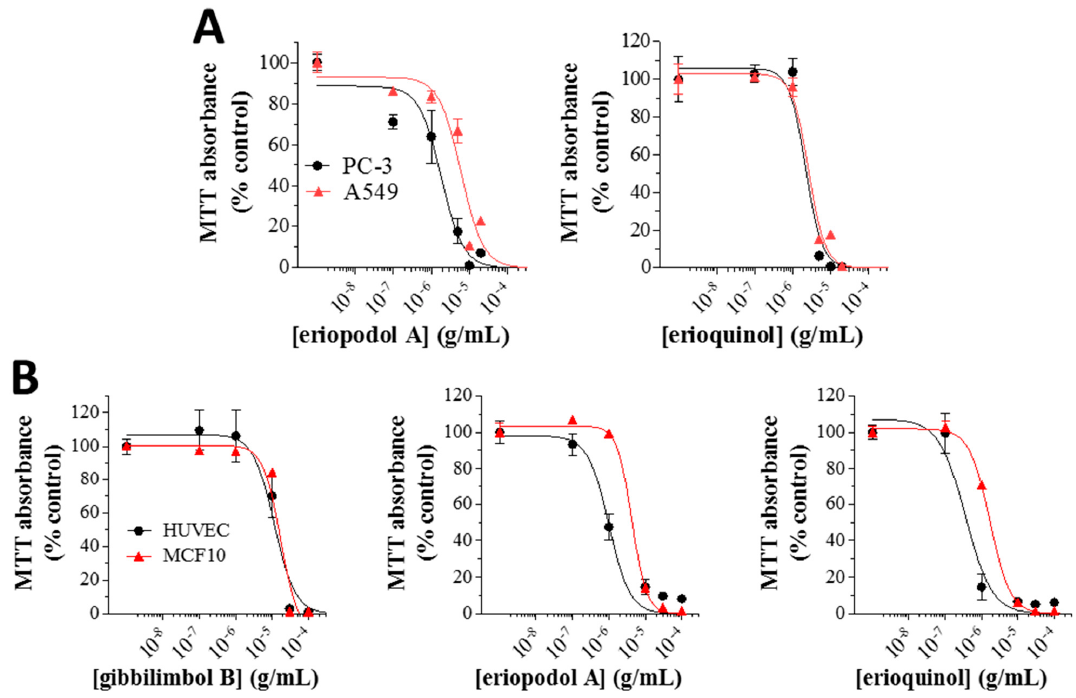
Figure 3. Piper genus-derived compounds exhibit cytotoxic effects in cancer and